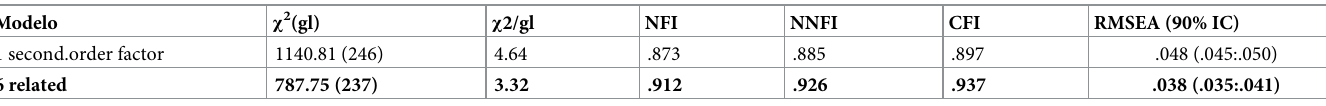
Table 4. The models’ fit indices are based on the confirmatory factor analysis of the 6-factor model related to a second-order factor and the 6-factor model related. Modelo χ 2 (gl) χ 2/gl